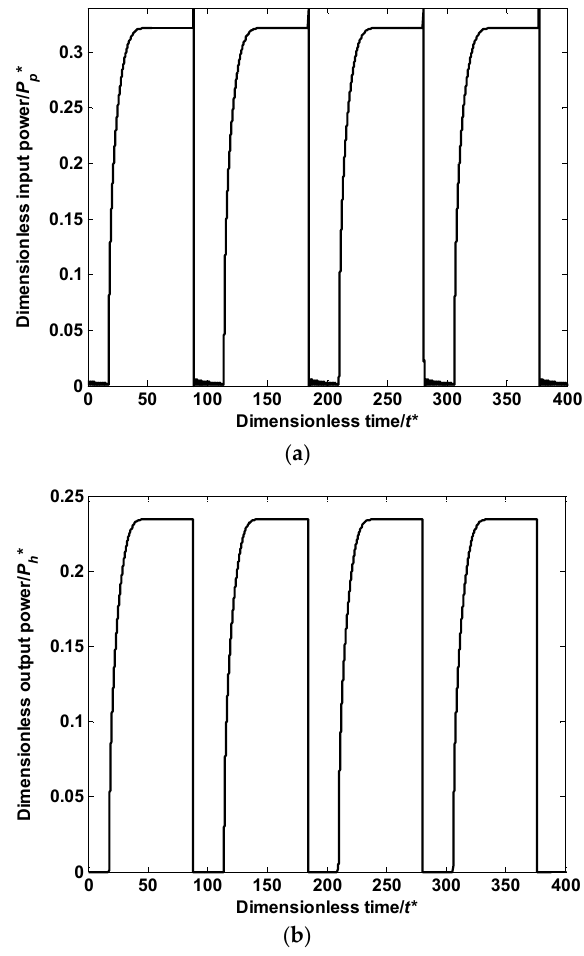
Figure 6. Dimensionless input power output power characteristics of the HP transformer. ( a ) Dimensionless input power of the HP transformer; ( b ) Dimensionless output power of the HP transformer.